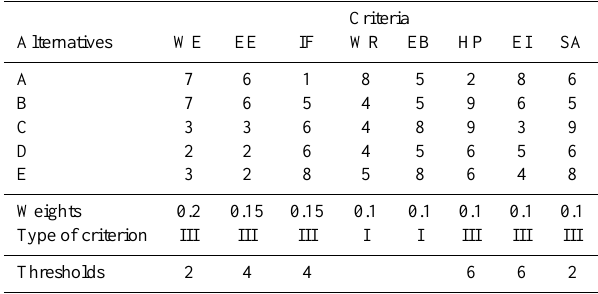
Table 2. Case I, Initial Matrix for La Estrella sub zone, with weights, type of criterion and thresholds, for